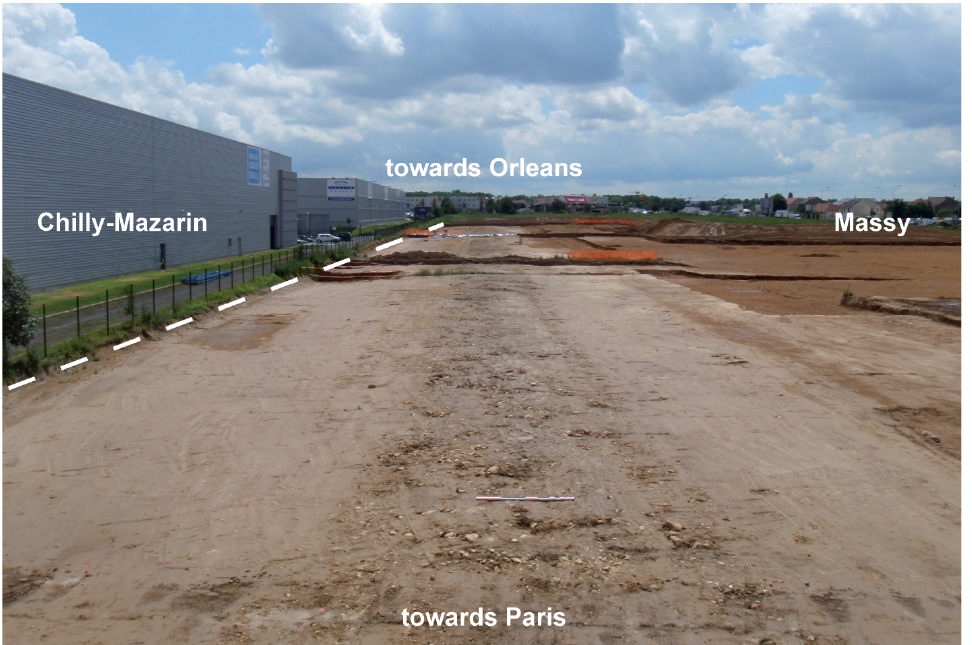
Figure 2. Last operating phase of the Old Path from Orleans to Paris as observed at Massy (Essonne)/Rue du Pérou before its replacement by the Great royal road . © J.